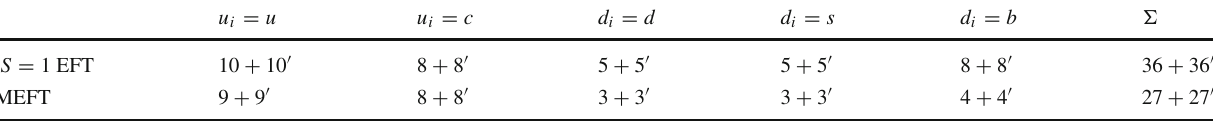
Table 1 Number of linearly independent four-quark operators with flavour content ( ¯ sd )( ¯ u i u i ) and ( ¯ sd )( ¯ d i d i ) in the (cid:3) S = 1 EFT with N f = 5 that contribute to ε (cid:2) /ε (first row). Number of non-vanishing